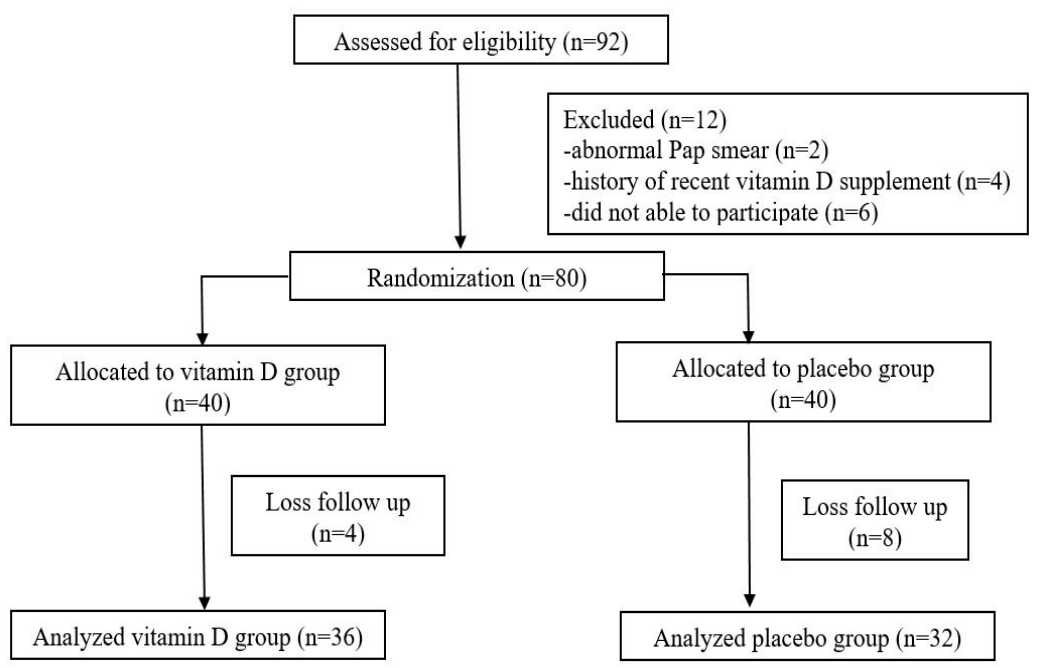
Figure 1. The study flow chart.